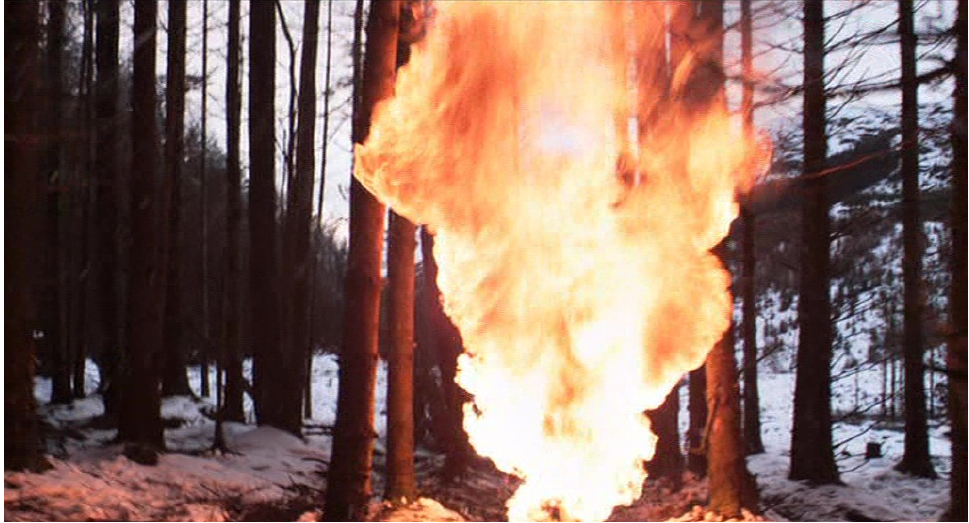
Figure 7: Under the Skin directed by Jonathan Glazer. 2013; London: BFI & Film 4.